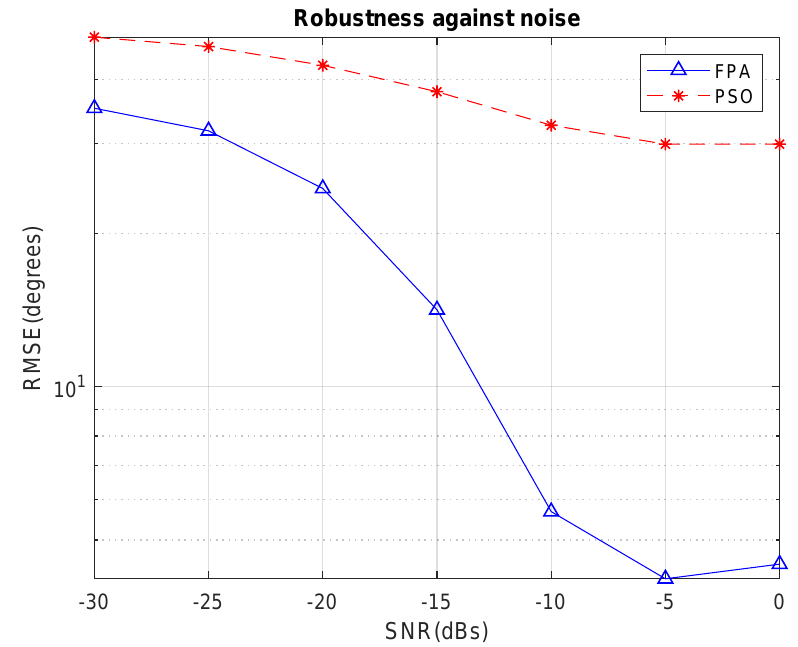
Figure 4. Robustness against noise for seven